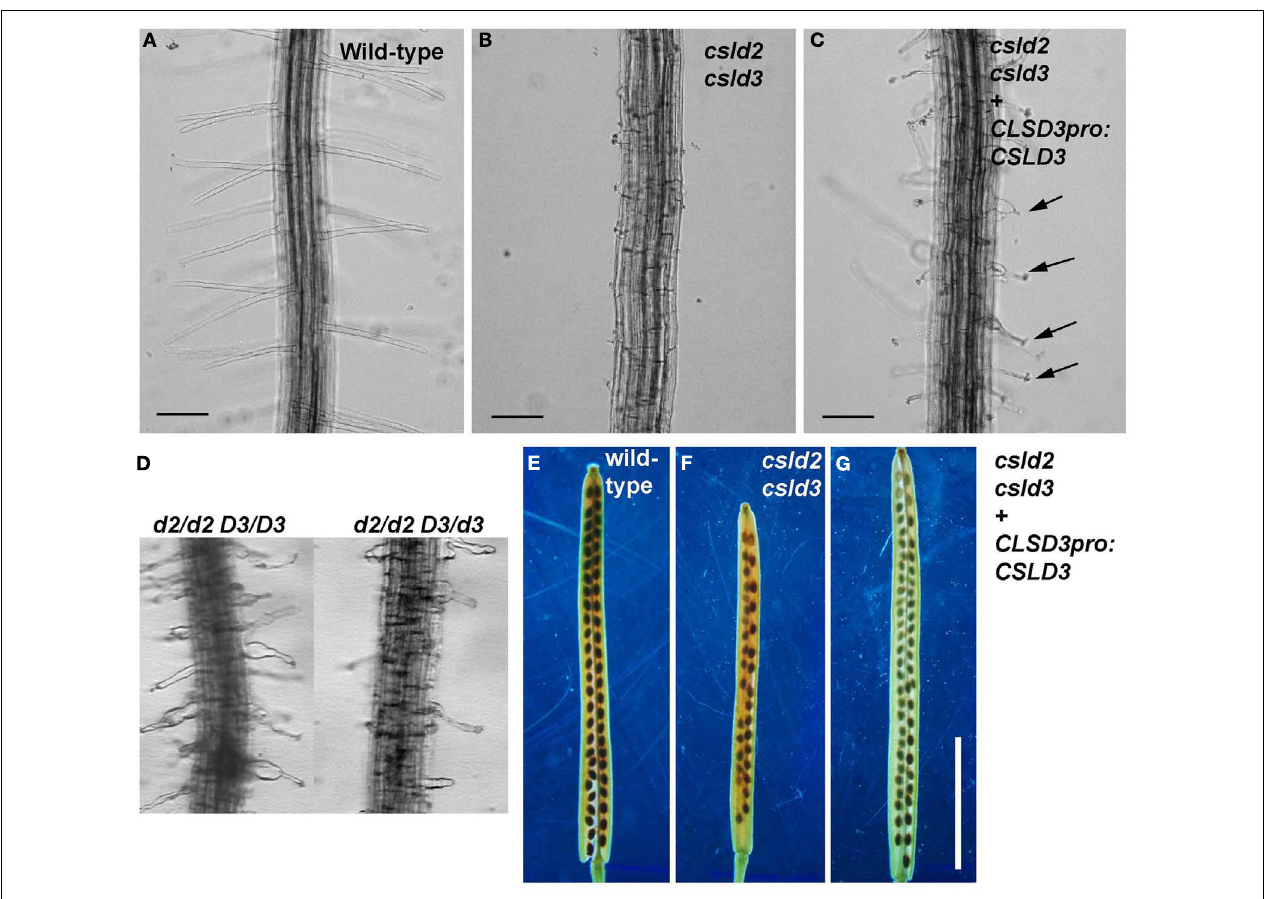
seedlings with one copy of CSLD3 (d2/d2 D3/d3) .The complemented csld2 csld3 line showed CSLD2 -like single mutant root hair phenotypes [arrows